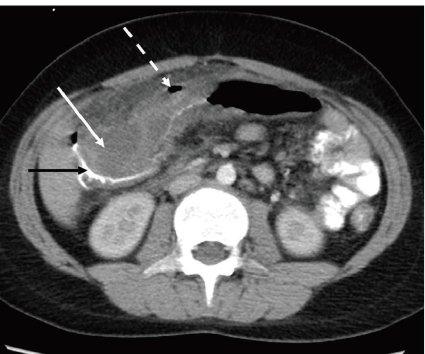
Figure 1: CT of abdomen and pelvis with intravenous and oral contrast showed severe wall thickening (black arrow) of the as- cending colon with adjoining phlegmon (white arrow), and small amount of adjacent free air suggesting contained perforation (dotted white arrow).